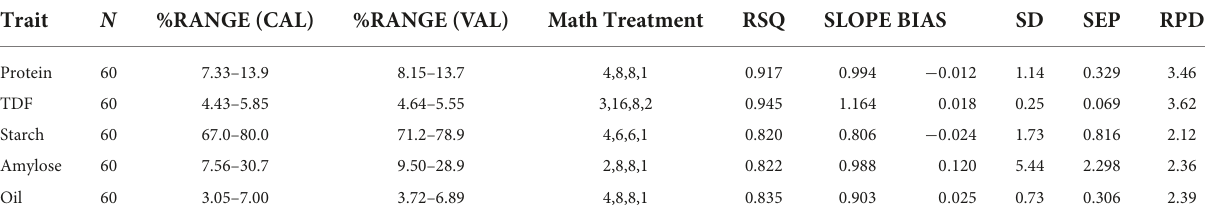
TABLE 3 Validation of NIRS models with brown rice